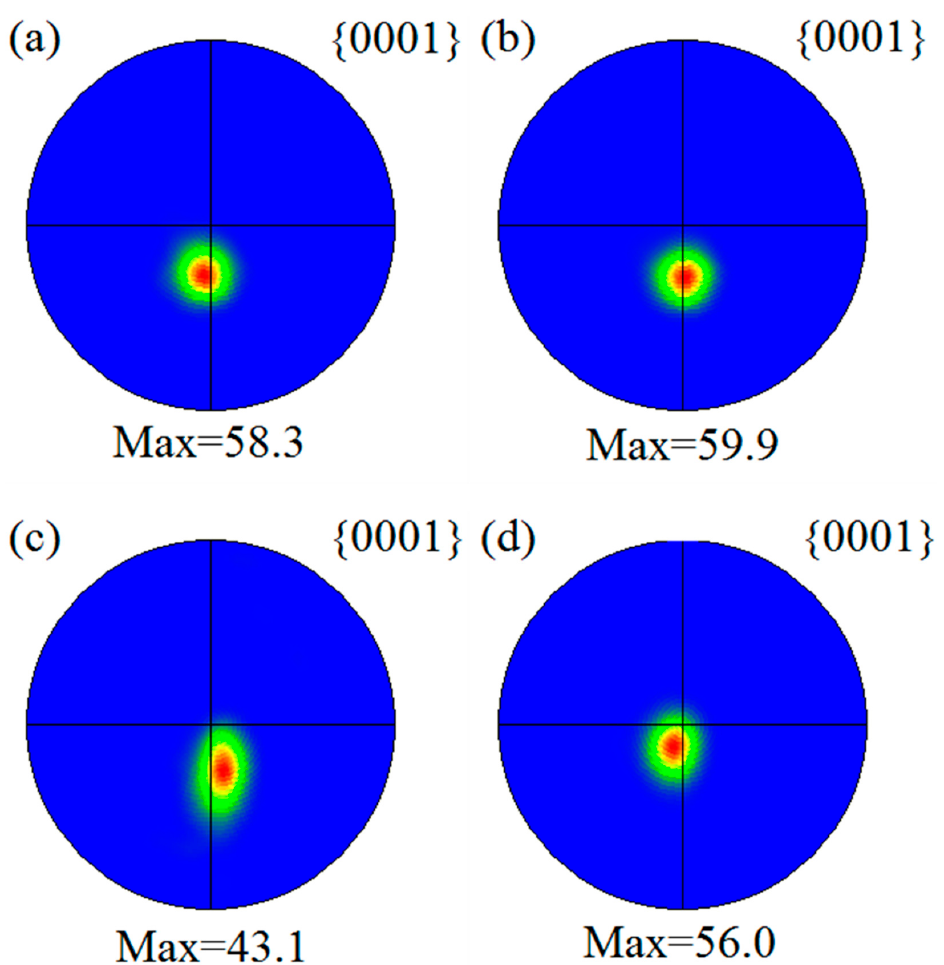
Figure 6. Pole figure maps of the SZ-2 mm and SZ-4 mm regions in the Mg-6Sn samples created using FSP obtained using EBSD: ( a ) SZ-2 mm region of the FSP1 sample, ( b ) SZ-2 mm region of the FSP2 sample, ( c ) SZ-4 mm region of the FSP1 sample, and ( d ) SZ-4 mm region of the FSP2 sample.